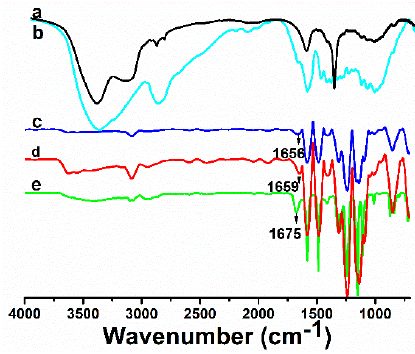
Figure 6. FTIR spectra of: ( a ) CNF; ( b ) LCN; ( c ) Sample M0 (PSF); ( d ) Sample M4 (CNF/PSF); and ( e ) Sample M10 (LCN/PSF).